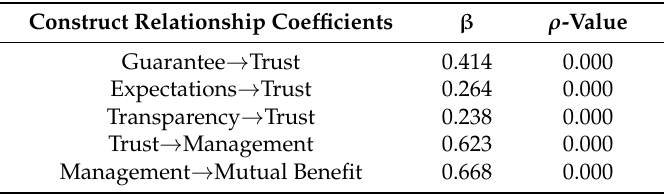
Table 5. Significance of path coefficients.